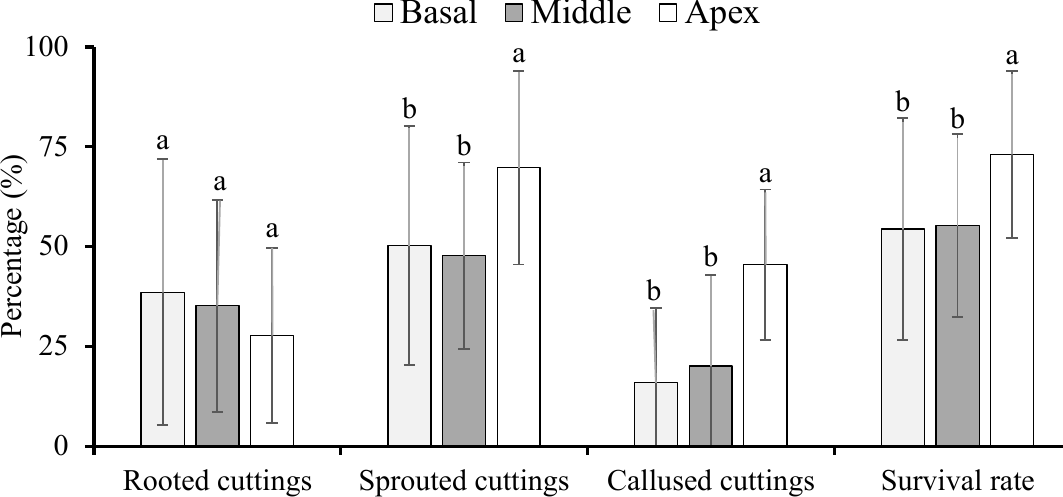
Figure 5. Percentage of rooted, sprouted, and callused cuttings and survival rate of Jatropha curcas L. hardwood cuttings extracted from different parts of the branch at 77 days after planting. Different letters above each bar indicate significant differences among the parts of the branch where the hardwood cuttings were extracted by the Least Significant Difference (LSD) test at the 5% probability level. Values are represented by the mean of four independent replicates.